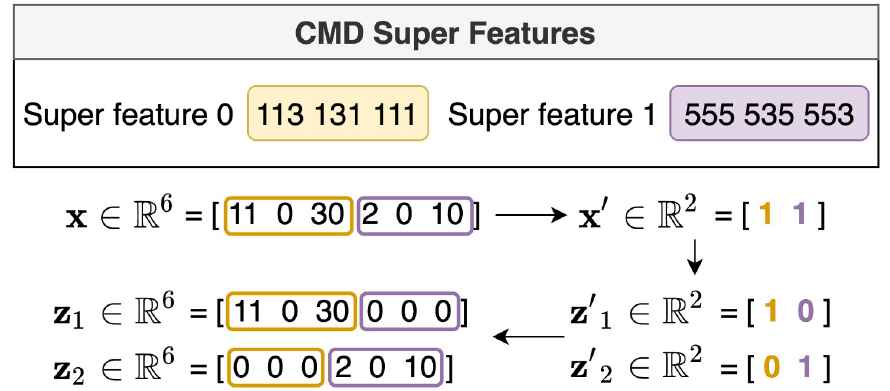
Fig 5. An example of constructing vectors for an interpretable model. An entry of a feature vector x denotes the number of occurrences of each n-gram sequence. For example, 11, 0, 30, 2, 0, and 10 are the numbers of occurrences of sequences 113, 131, 111, 555, 535, and 553 in an instance, respectively. x , z 1 , and z 2 are defined in the original feature space while x 0 , z 0 1 , and z 0 2 are represented using super features.